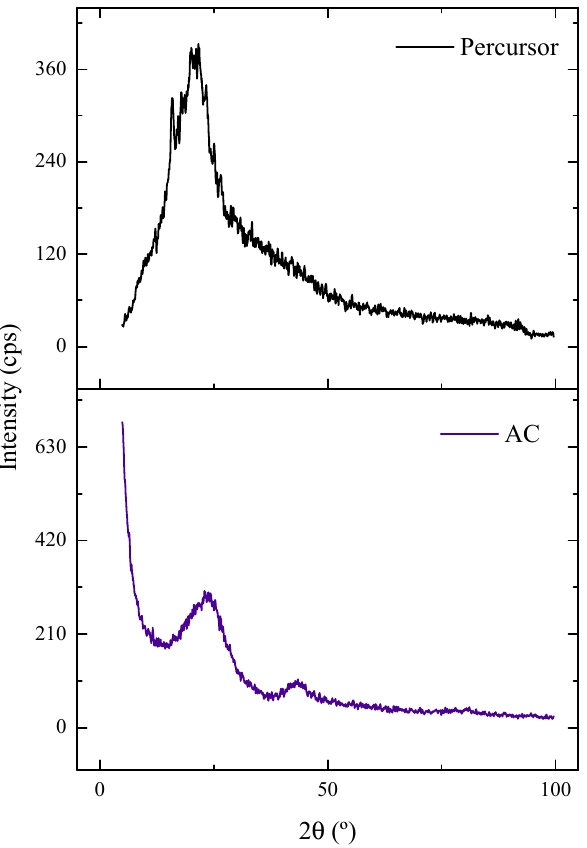
Figure 4. XRD patterns of the precursor material and AC.